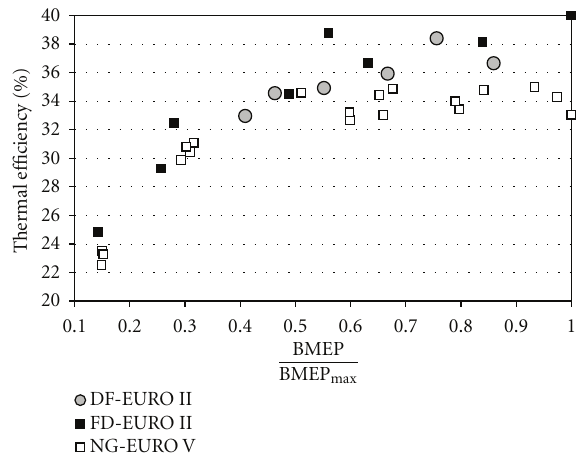
Figure 9: Thermal e ffi ciency for DF, FD, and full NG engines measured in the condition of Figure 4.